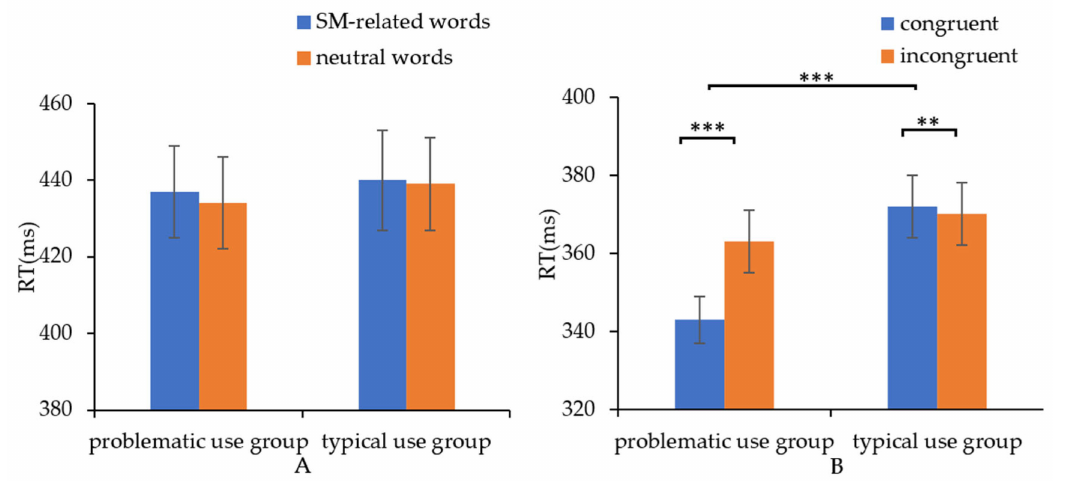
Figure 3. The mean RT of all the conditions in the Stroop task and DPT. ( A ) No significant differ‑ ence was found between the problematic use group and the typical use group in the Stroop task. ( B ) Problematic users reacted faster to the congruent condition than to the incongruent condition, while typical users reacted more slowly to the congruent condition than to the incongruent condi‑ tion in the DPT. ** p < 0.01, *** p < 0.001.